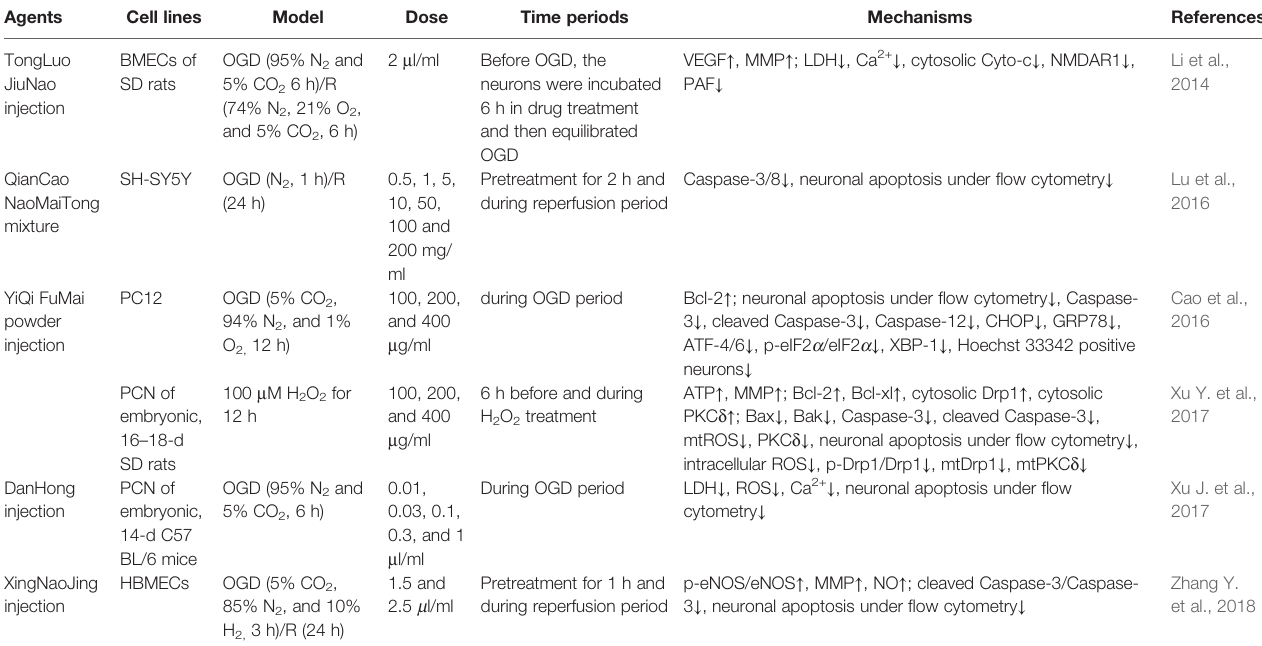
TABLE 2 | The in vitro mechanism underlying the inhibition of MPTP opening-induced neuronal apoptosis by authorized drugs in the treatment of ischemic stroke.